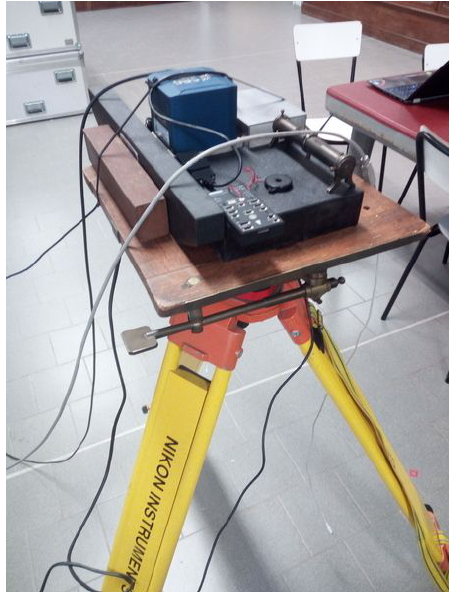
Figure 1. The two IMUs under study mounted on a leveled non-magnetic plate for static logging at DIATI’s laboratories.